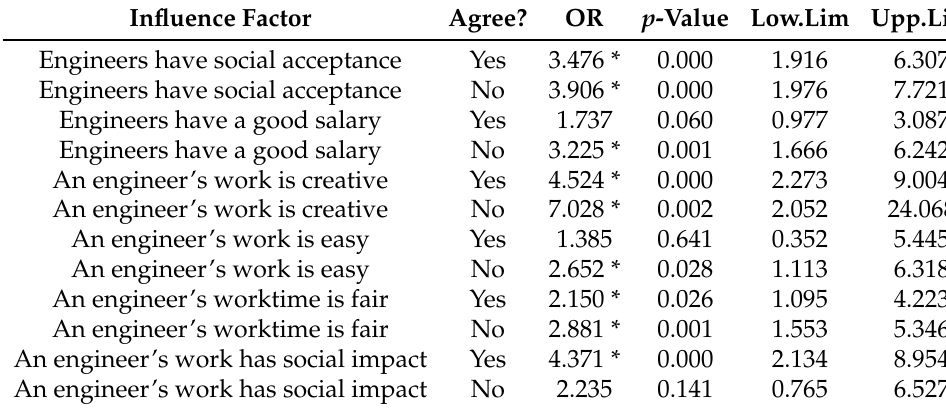
Table 5. Odds ratios, p -values and confidence intervals obtained for the study of the advantage for male versus female students in agreeing with the questions in column “Influence factors”. An * indicates statistical significance at level